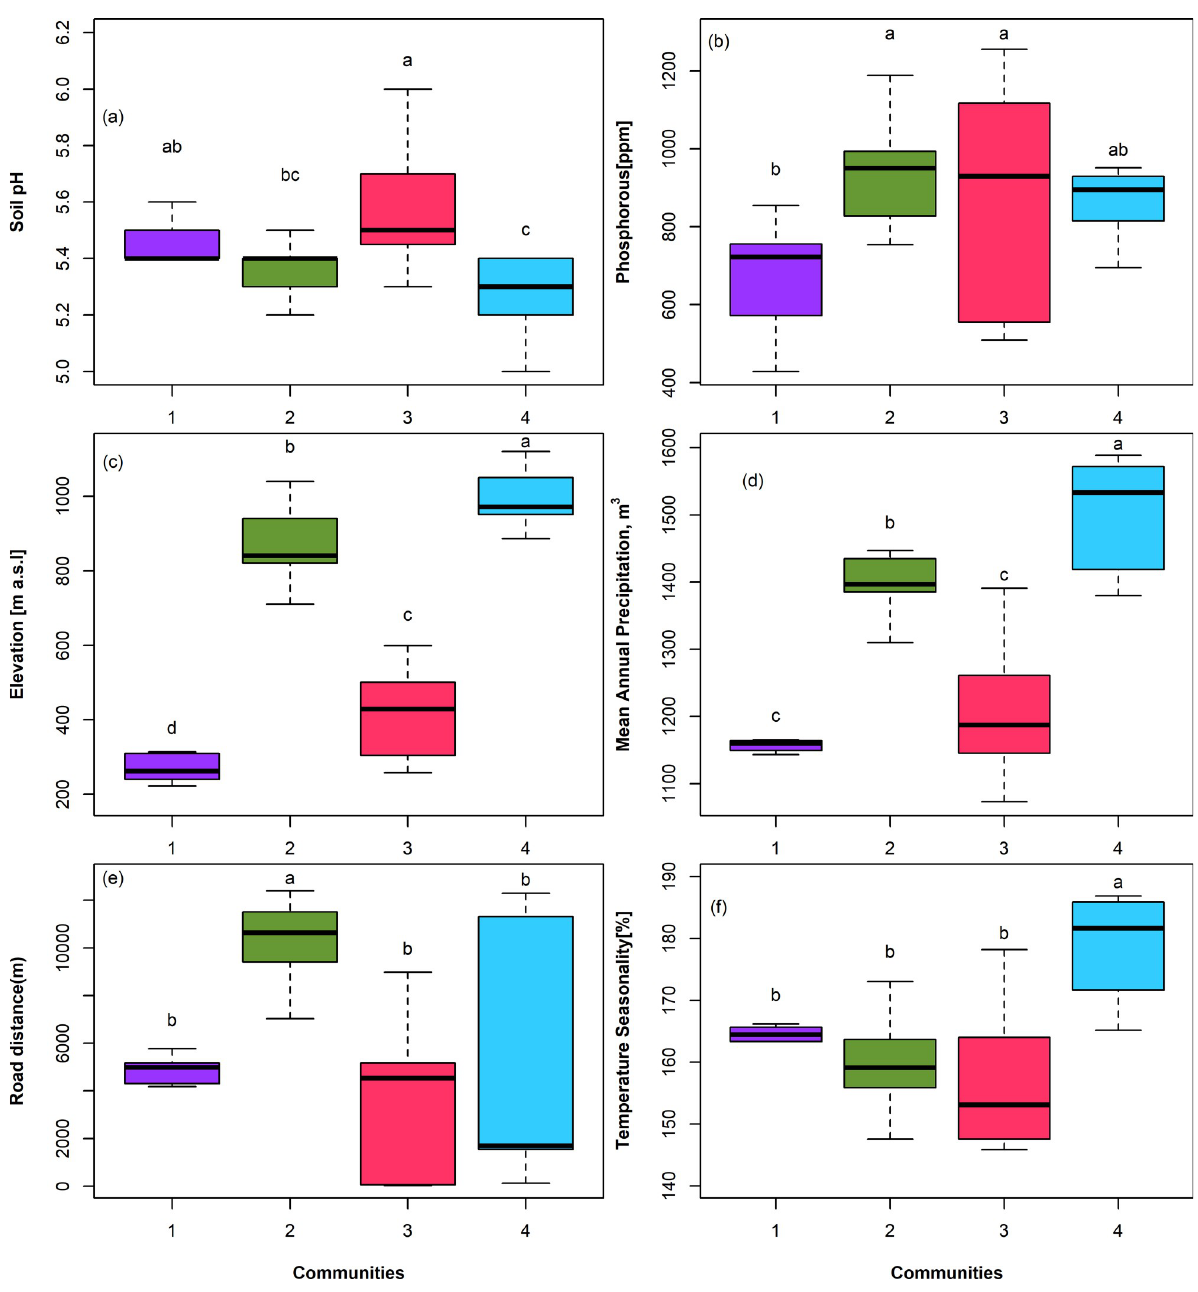
Fig 5. Boxplot showing difference among individual communities with respect to environmental and disturbance factors. The horizontal line crossing the box in the center represents the median; the box represents the 25 th and the 75 th percentiles. The vertical line outside the box represents the minimum and maximum values. Difference in letters (a, b, c, d) signifies that the communities are different in the specified factor. Communities: 1 = Tabernaemontana ventricosa-Leptonychia usambarensis, 2 = Ficus sur- Myrianthus holstii, 3 = Artocarpus heterophyllus-Lecaniodiscus fraxinifolia, 4 = Isoberlinia schefflera- Sorindeia